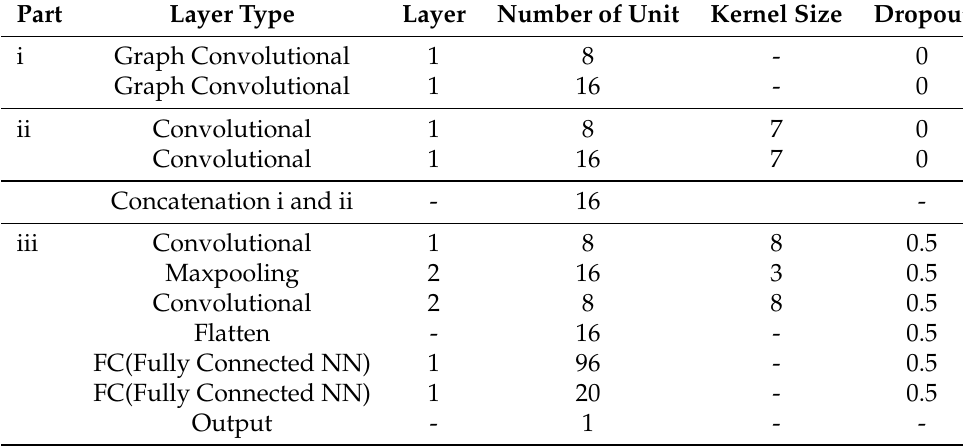
Table 1. Layer descriptions of the proposed method: the first part of the graph convolutional network is composed of two graph convolutional layers, the second part is 1D convolutional for hand engineered input data and the third part of the layers comprise 1D convolutional, maxpooling, and fully connected layer for the concatenated input from part i and ii.